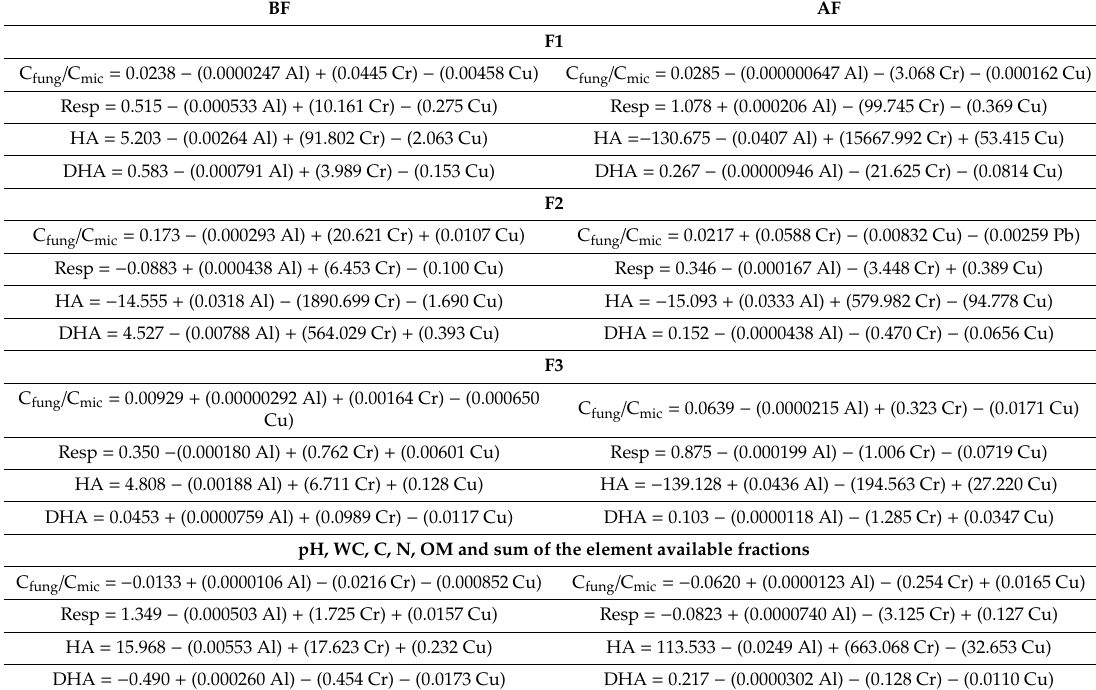
Table 3. Multiple regressions ( p < 0.05) among soil pH, water content (WC), organic matter content (OM), total content of C and N and available fractions (F1, F2, F3) of element contents and biotic variables measured before (BF) and after fires (AF) in soils collected inside the Vesuvius National Park. BF